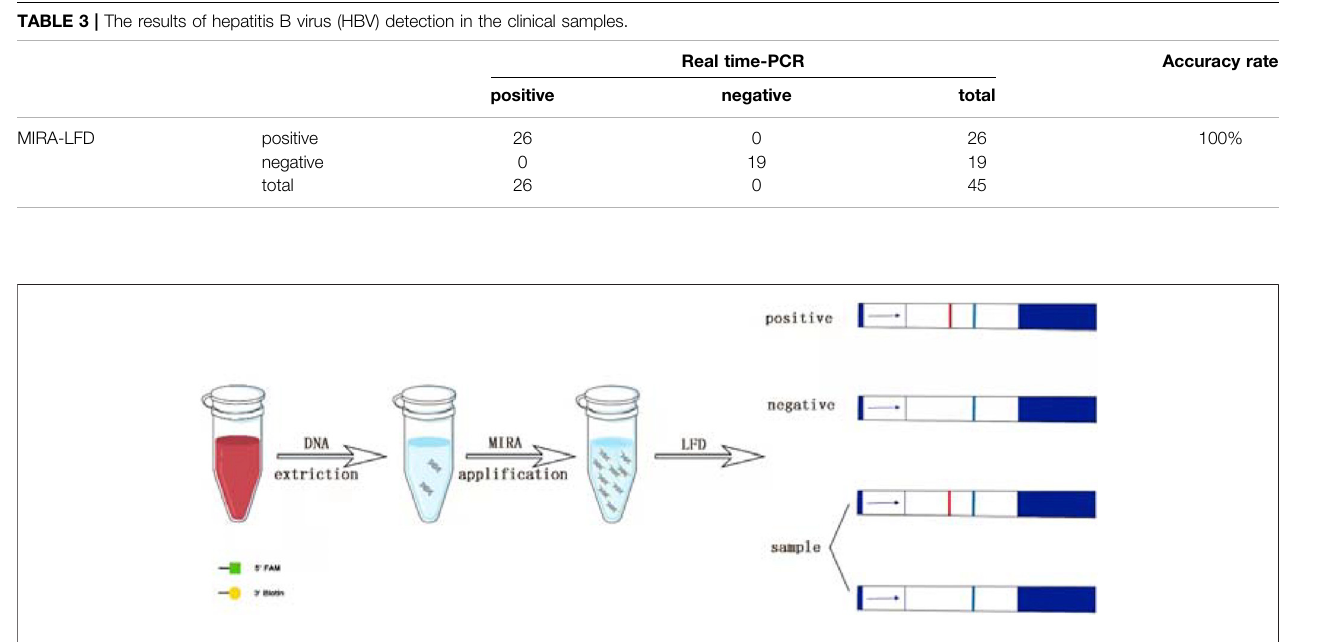
FIGURE 7 | Scheme summarizing the entire